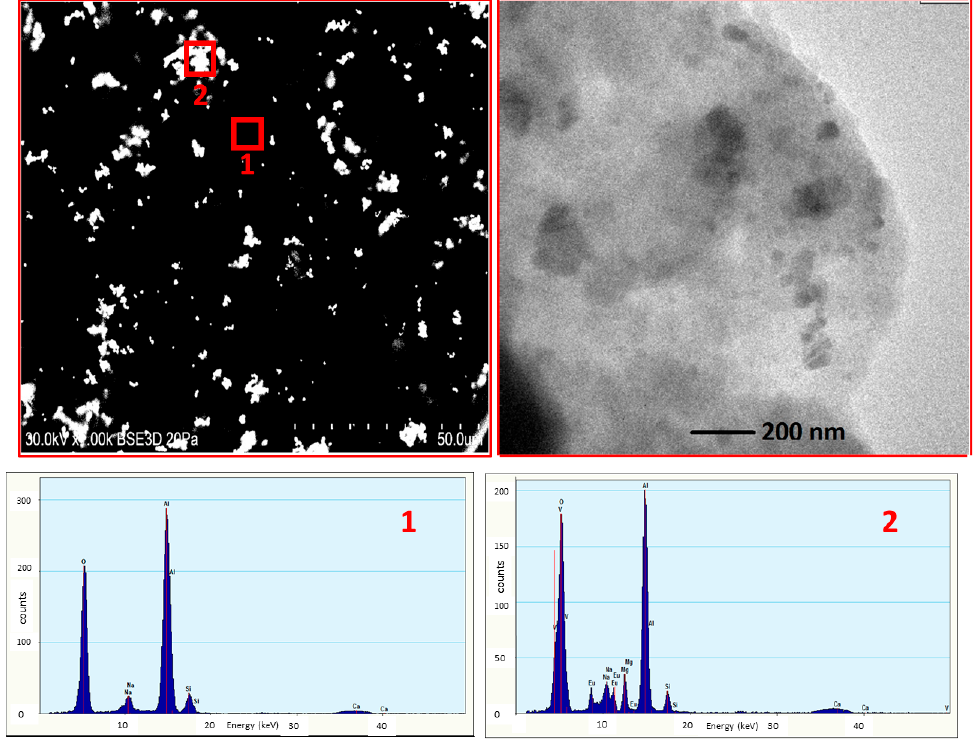
Figure 2. Black/bright field scanning electron microscopy (SEM) images of Ca 2 NaMg 2 V 3 O 12 : Eu 3+ in in glass with energy dispersive spectroscopy (EDS) for the glass region, marked as “1” and for the phosphor region, marked as “2”.